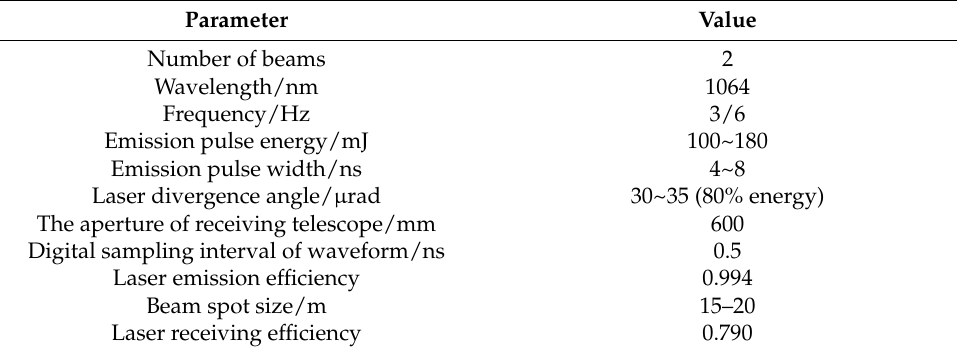
Table 1. Main technical performance parameters of the laser.